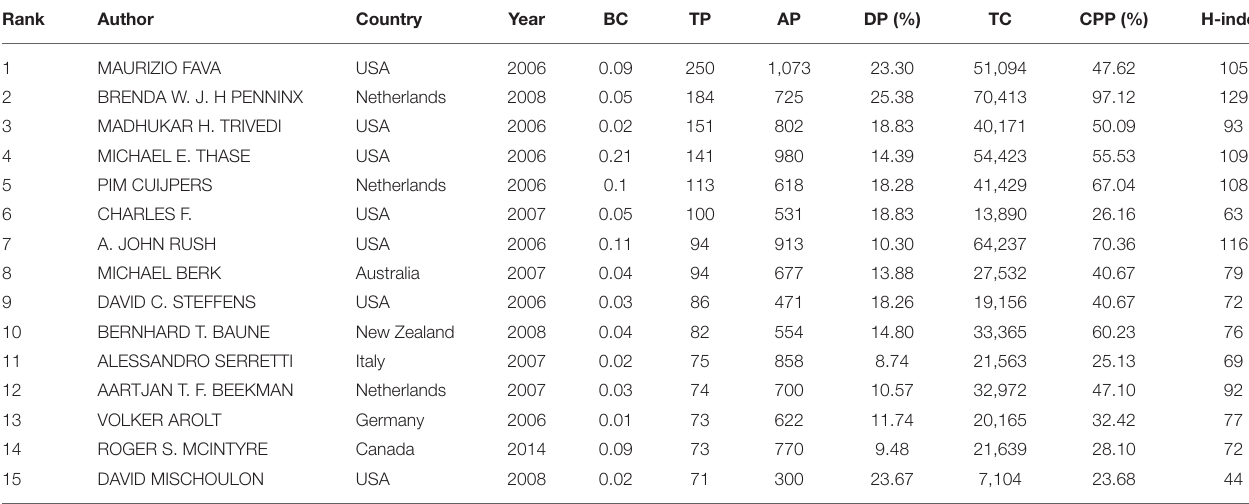
TABLE 4 | The top 15 authors in network of co-authorship, 2004–2019.